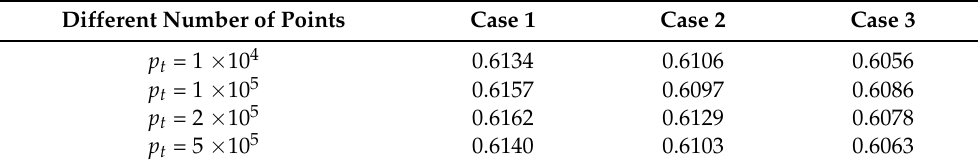
Table 1. Coverage rates for different number of test points in Monte Carlo calculation.